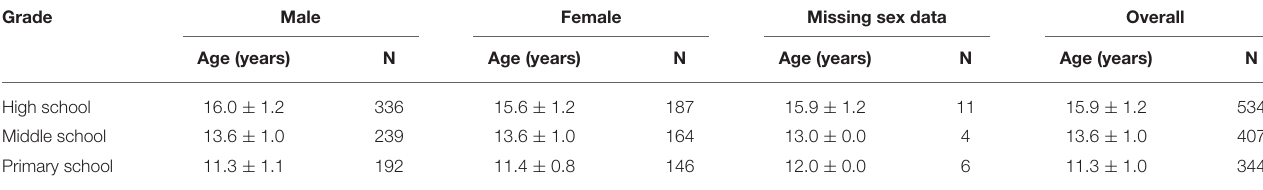
TABLE 1 | Demographic data of students of various grades.